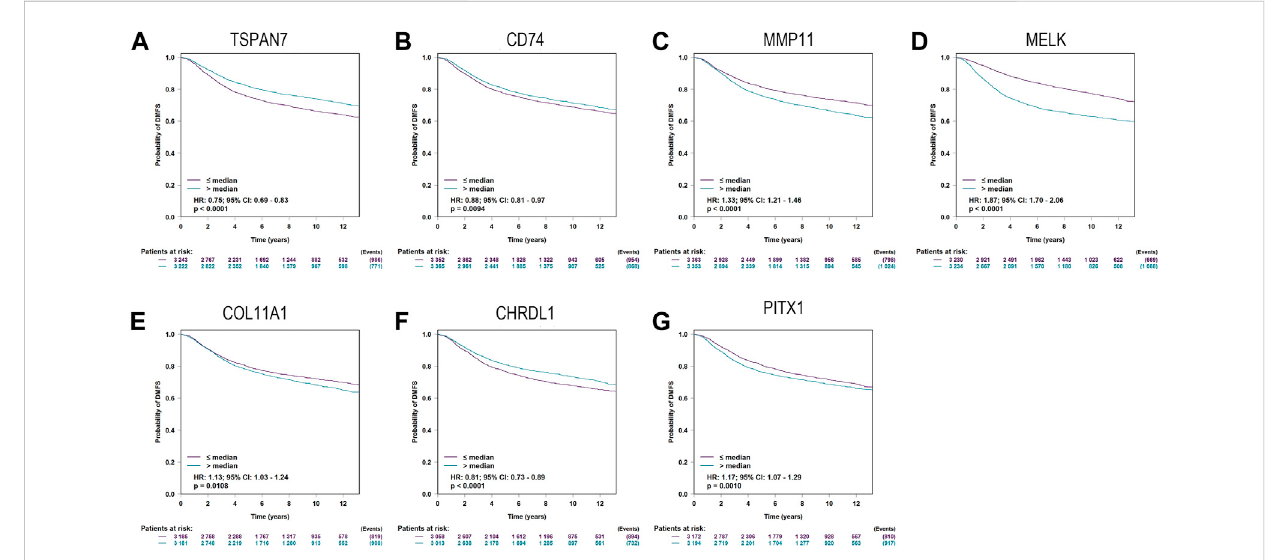
FIGURE 5 Kaplan-Meier curves for Distant metastasis-free survival (DMFS) of TSPAN7 (A) , CD74 (B) , MMP11 (C) , MELK (D) , COL11A1 (E) , CHRDL1 (F) , and PITX1 (G) in breast cancer patients using